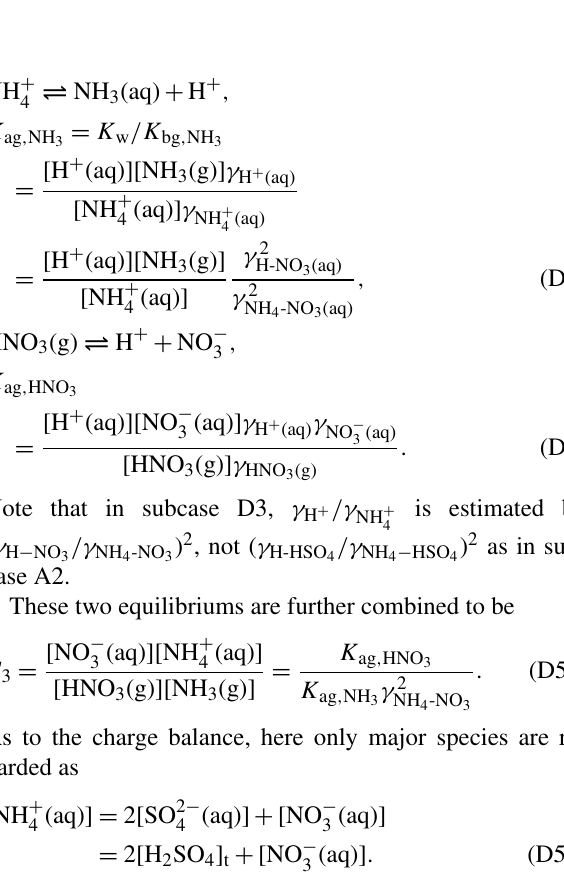
Figure D2. Comparison of activity coefficients for different species. (a–c) Comparison of activity coefficients involved in ISORROPIA A2 subcase calculations, as predicted by ISORROPIA and E-AIM. (d) Comparison of activity coefficients involved in ISORROPIA D3 subcase calculations, as predicted by ISORROPIA and E-AIM. (e) Mean activity coefficients predicted by ISORROPIA that are involved in ISORROPIA G5 subcase